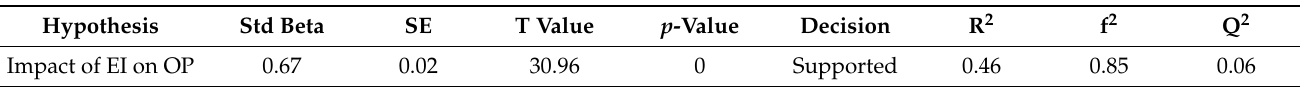
Figure 3. Areas of concern regarding the impact on Emotional Intelligence (EI).